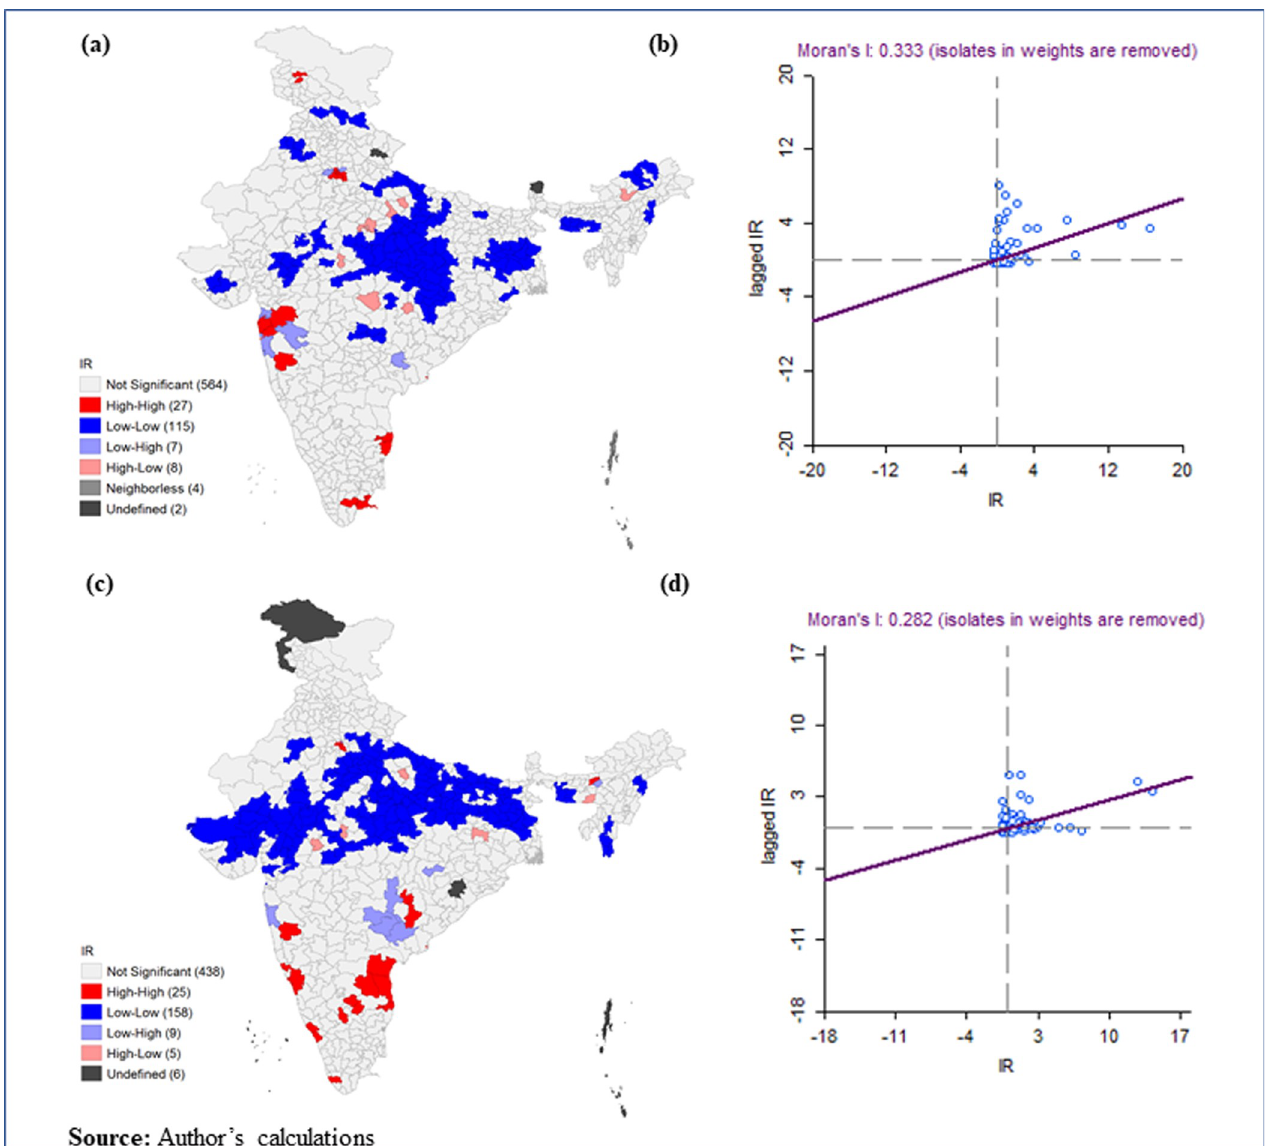
Fig 4. Moran’s I and LISA cluster maps for district infection ratio of COVID-19 in India for July 31, 2020 and October 31, 2020. (a). LISA cluster map, July 31, 2020; (b). Moran’s I, July 31, 2020; (c). LISA cluster map October 31, 2020; (d). Moran’s I, October 31, 2020.